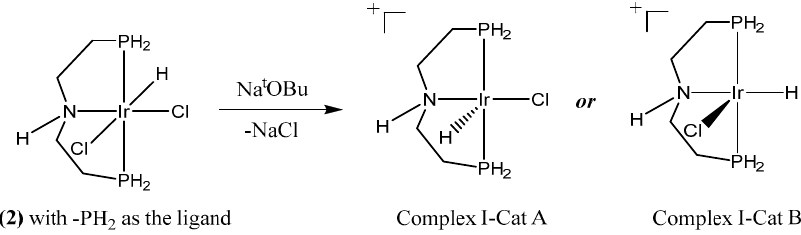
Figure 3. Possible geometries of the products from the reaction of catalyst precursor (2) with strong base.